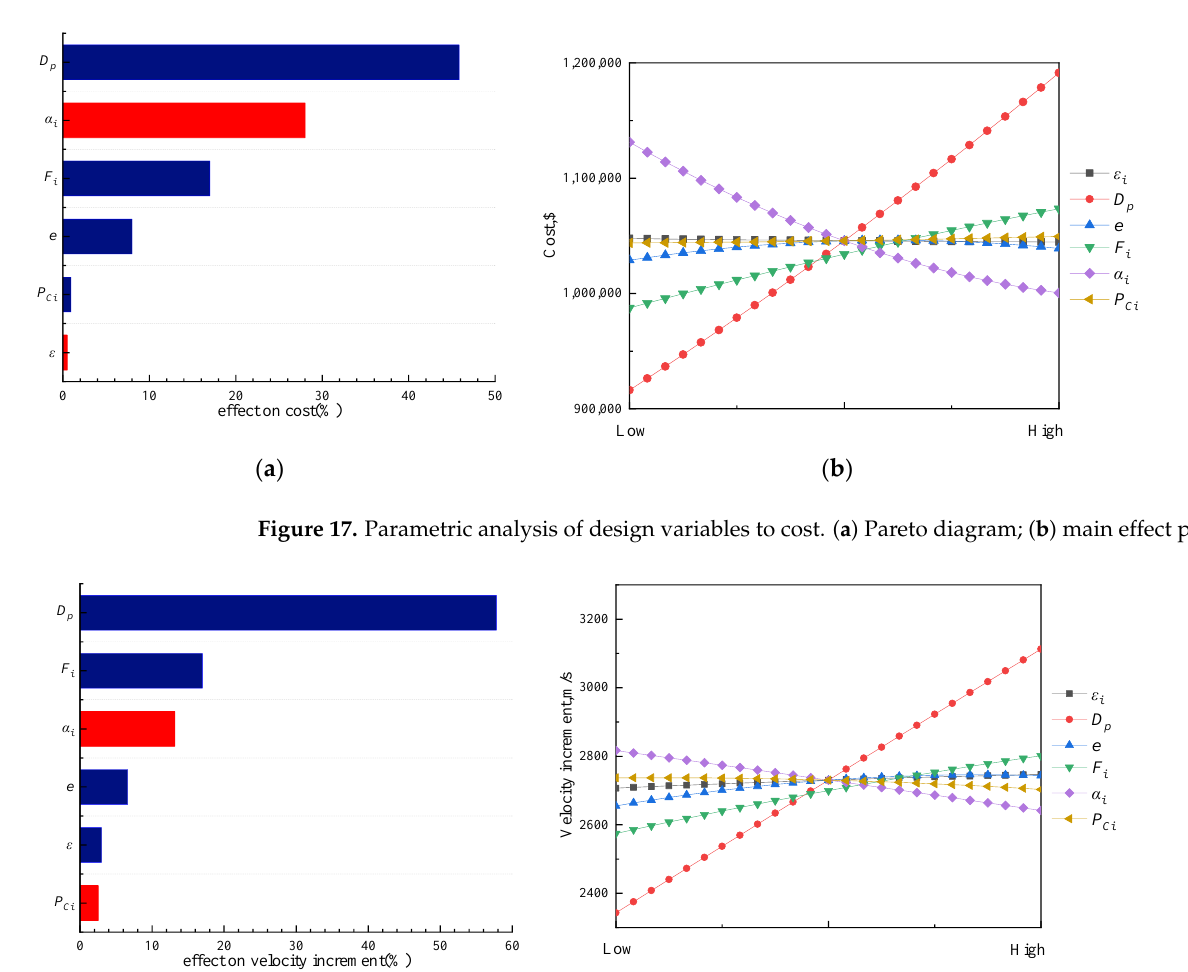
Figure 16. Parametric analysis of design variables to mass. ( a ) Pareto diagram; ( b ) main effect plot.